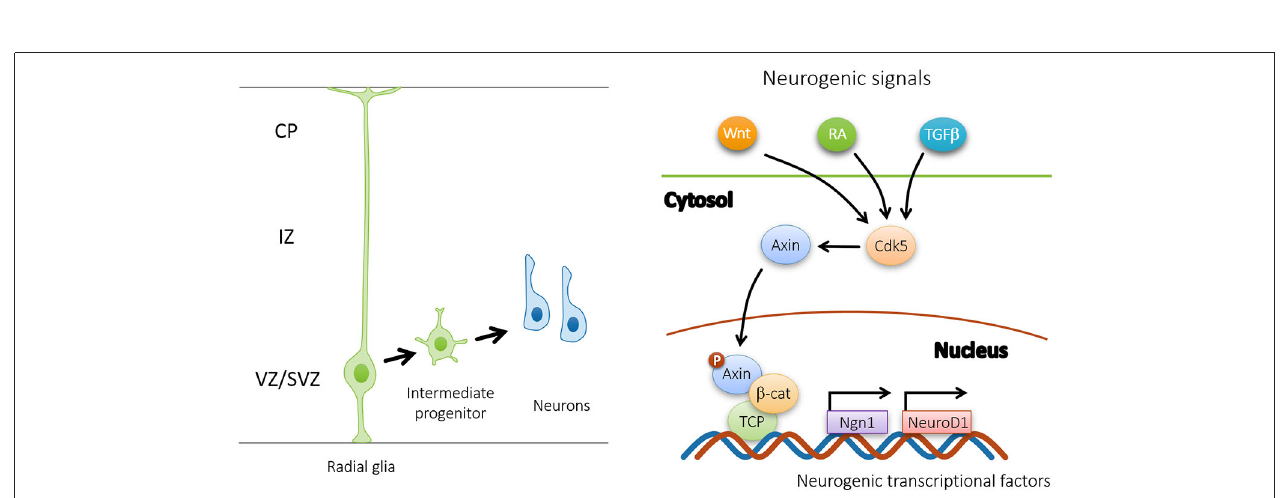
FIGURE 3 | Upon Cdk5 phosphorylation, Axin promotes the differentiation of intermediate progenitors by interacting with β -catenin in the nucleus . In response to neurogenic signals (Wnt, RA, TGF β , etc.), nuclear Axin forms complex with β -catenin and TCP to activate downstream neurogenic transcriptional factors, such as Ngn1 and